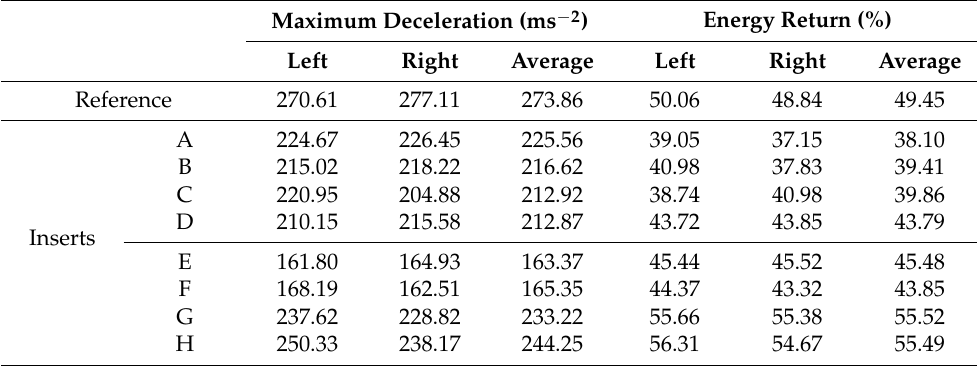
Table 2. Results of the dynamic impact tests obtained with the reference slippers and the eight pairs of prototype